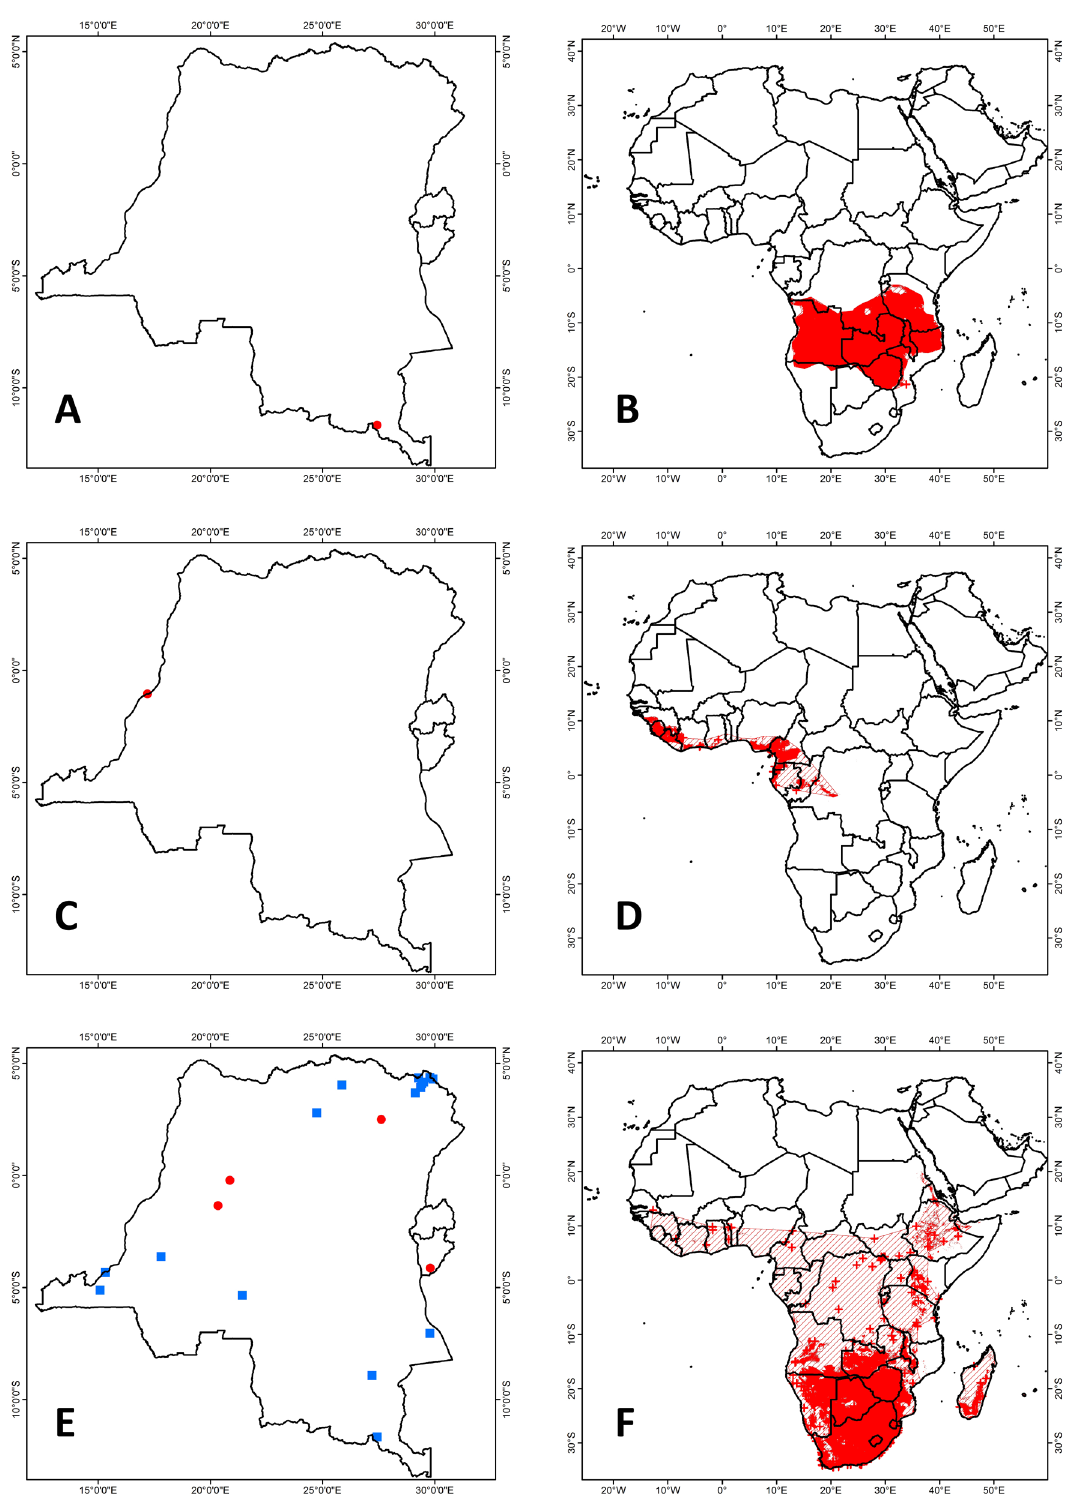
Fig. 43. Distribution maps. A–B . Mimetillus thomasi Hinton, 1920. C–D . Neoromicia brunnea (Thomas, 1880). E–F . Neoromicia capensis (A. Smith, 1829). A, C, E. Distribution in the CRB area. B, D, F.